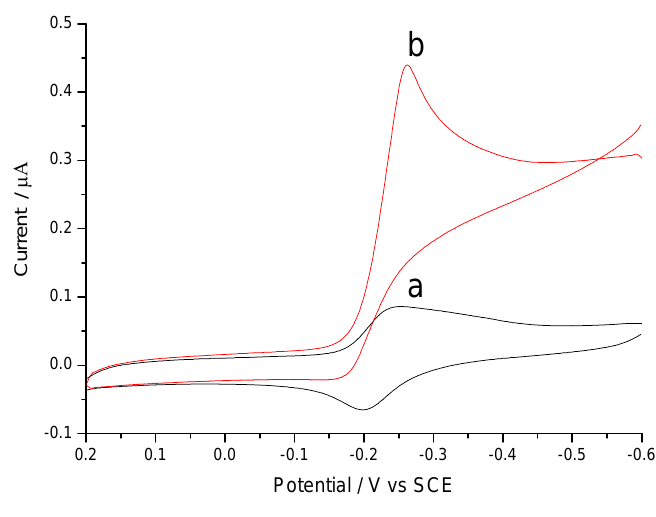
Figure 2. Cyclic voltammograms of the H the presence of 2.5 mM H